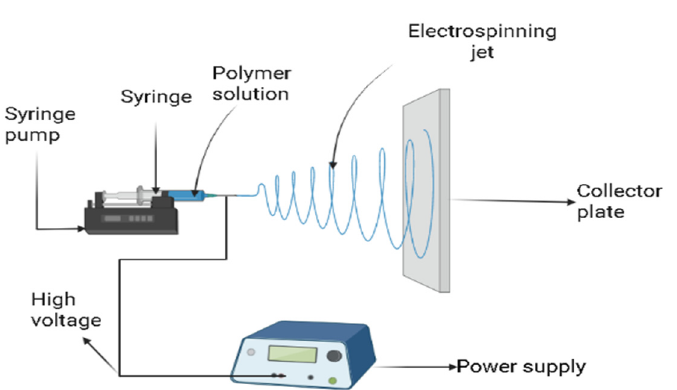
Figure 1. Electrospinning setup.